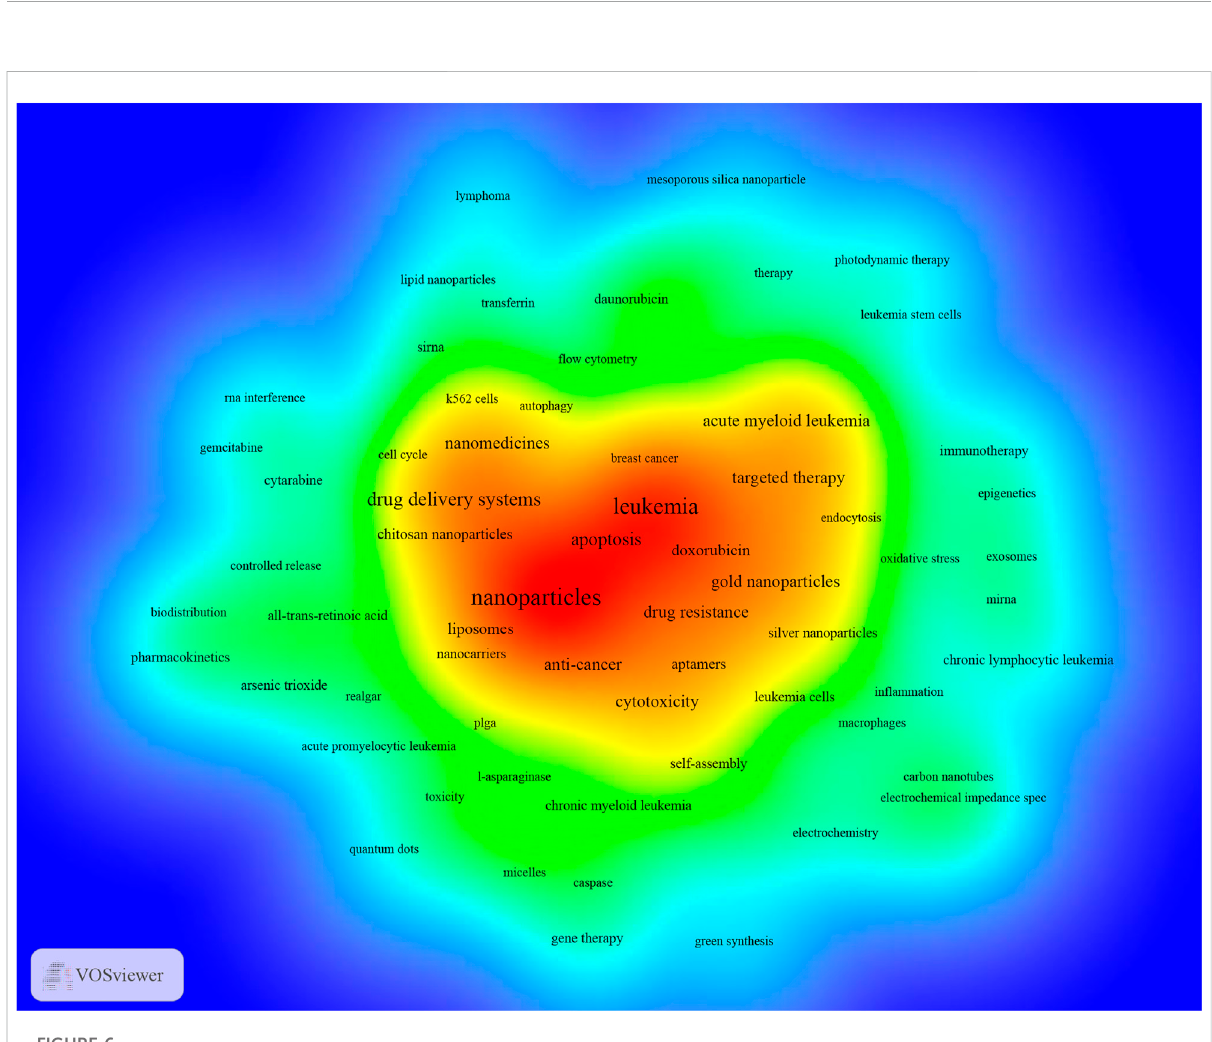
Frontiers in Bioengineering and